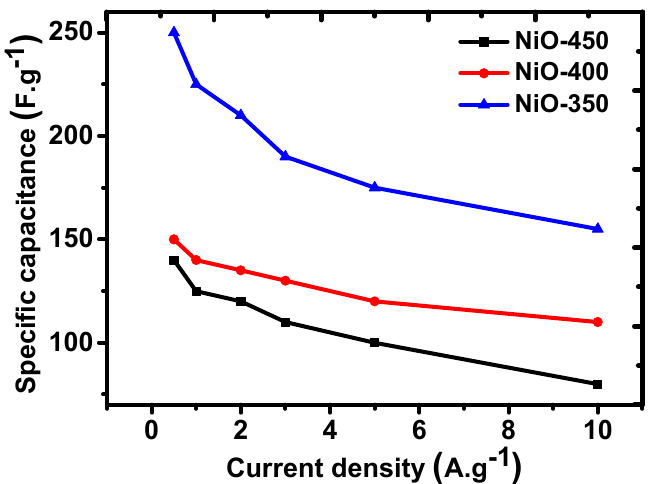
Figure 7. Specific capacitance using the MW-assisted synthesis of NiO nanoparticles.